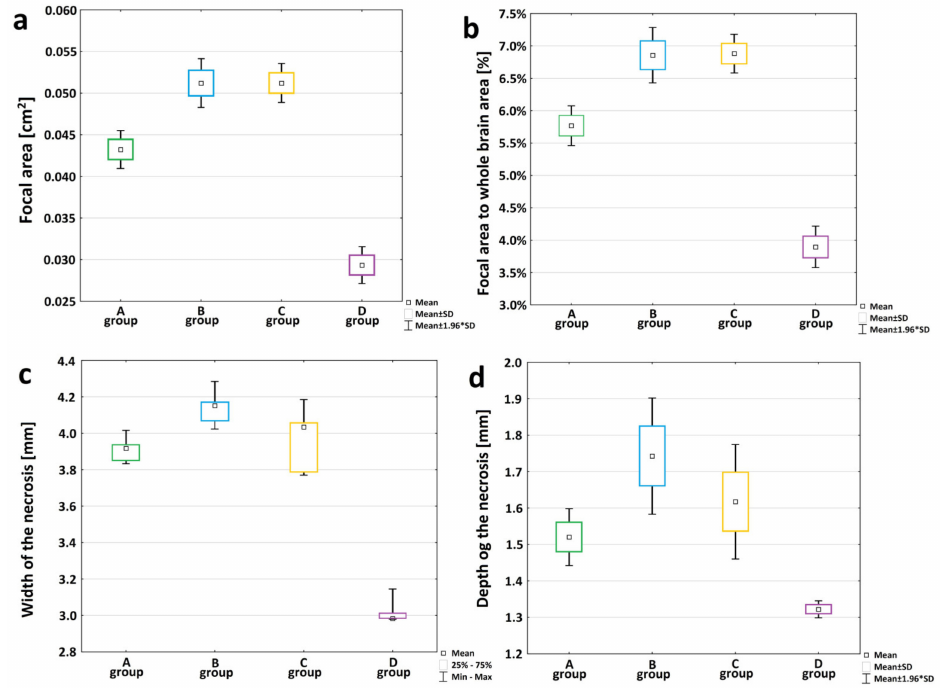
Figure 3. Comparison of ischemic area dynamics related to the changes after ischemic stroke induction in rats. Nissl staining; ( a ) the graph shows a comparison of the mean focal area [cm 2 ] of necrosis within Groups A, B, C and D: ANOVA, F (3, 16) = 336.64, p = 0.000001, post-hoc Bonferroni’s test for each pair p < 0.001; ( b ) the graph shows a comparison between the focal area vs. the whole brain area [%] in Groups A, B, C and C: ANOVA, F (3, 16) = 322.59, p = 0.000001, post-hoc Bonferroni’s test for each pair p < 0.001; ( c ) the graph shows that the “width” of the necrosis spread after stroke induction differs among all pairs: Kruskal–Wallis test [H (3, N = 20) = 14.15429 p = 0.0027; Dunn’s post-hoc test indicates that there was a statistically significant difference between Groups B and D ( p = 0.0014); ( d ) the graph shows that the “depth” of the necrosis spread after stroke induction differs among all pairs (following post-hoc Bonferroni’s test: for pair Group A vs. Group B p = 0.000171, for pair Group A vs. Group D p = 0.000578, for pair Group B vs. Group C p = 0.029973, for pair Group B vs. Group C p = 0.0000001, for pair Group C vs. Group D p = 0.000006), with the exception of Group A vs. Group C: no statistically significant difference following post-hoc Bonferroni’s test p =